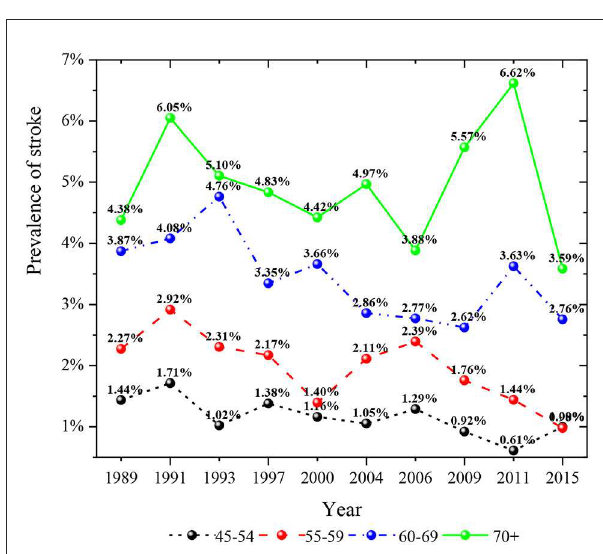
FIGURE5 Prevalence of stroke in different age groups in 1989–2015.